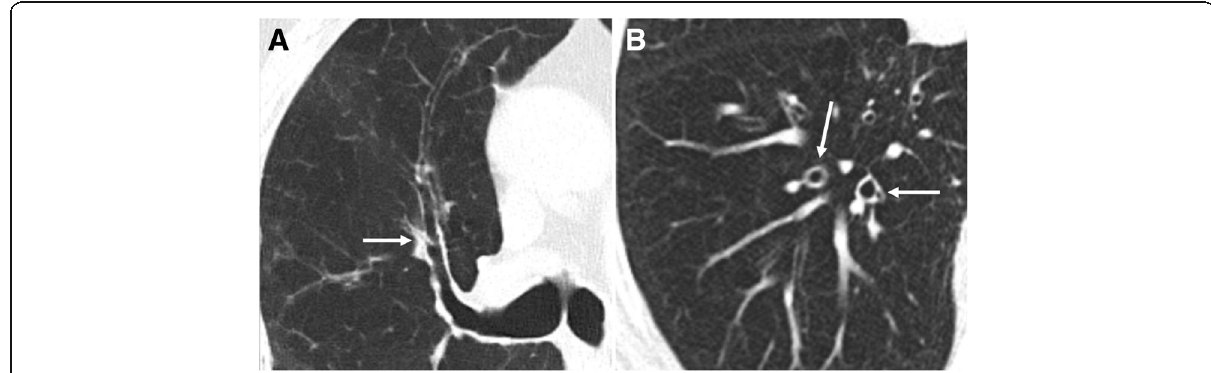
Fig. 2 Bronchial wall thickening in a 79-year-old heavy smoker man. a and b Axial images from a chest CT show thickening of the bronchial walls (arrows). Bronchial wall thickening is an important predictor factor of FEV1 and of the risk of acute